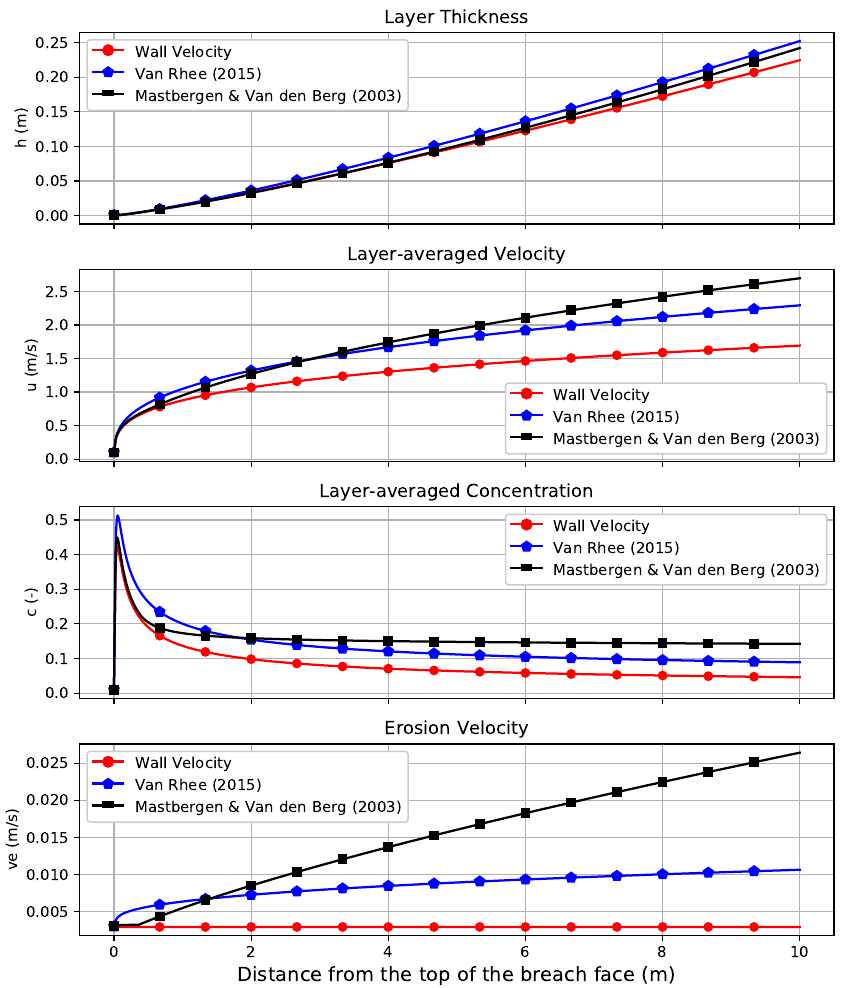
Figure 9. Comparison of the numerical steady-state results using different erosion formulas; D 50 = 0.100 mm, α = 60 ◦ , φ = 30 ◦ , C f = 0.02 (Run 4 from Table